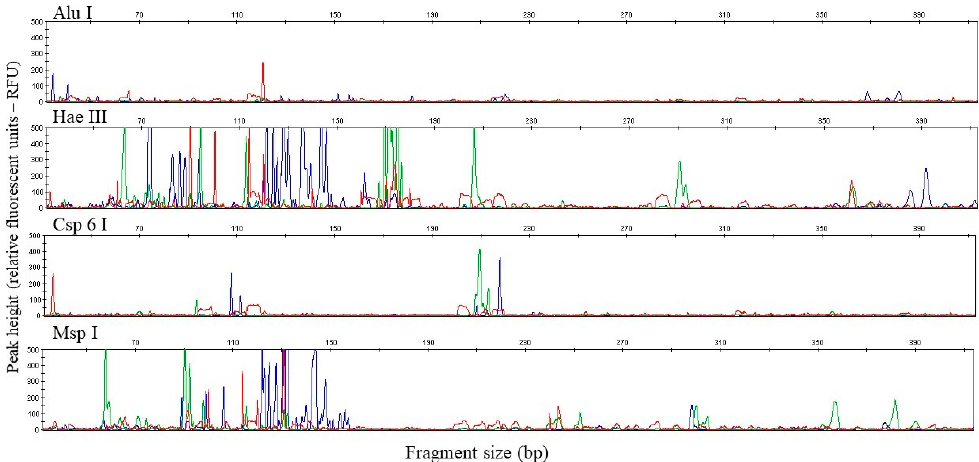
Figure 1. Exemplary electropherograms of T-RFs, the results of multiplex PCR products digestion (obtained for samples from soil 1–S1) with the restriction endonucleases: AluI, HaeIII, Csp6I, MspI. The blue color of peaks represent T-RFs of the PCR products labelled with 6-FAM of the fungal primer. The green and red peaks are the bacteria (HEX) and archaea (ROX), respectively. The T-RF length and height were identified with reference to the internal size standard (LIZ- orange dye) which is not shown in the figures. Explanations: 6-FAM,